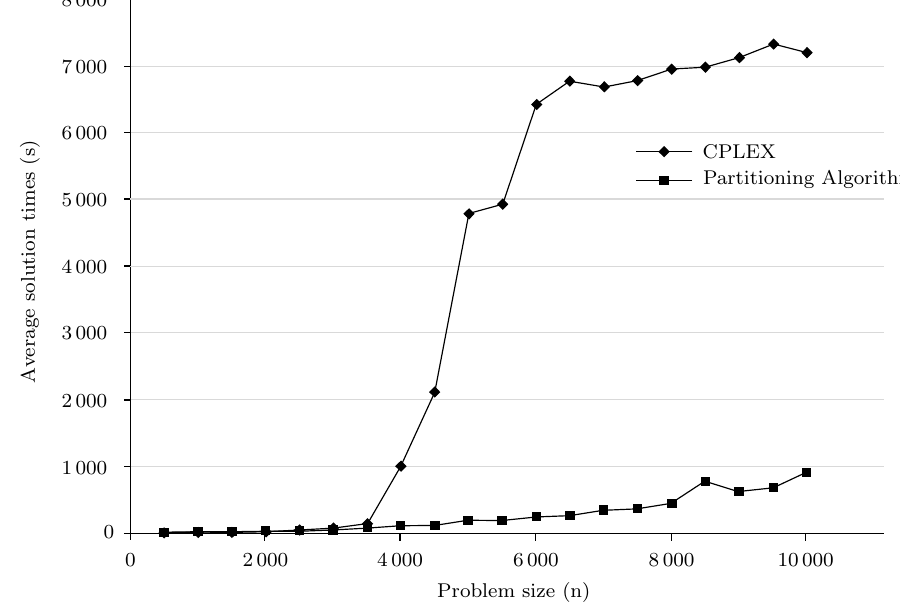
Figure 5: Average solution times for the patitioning algorithm and